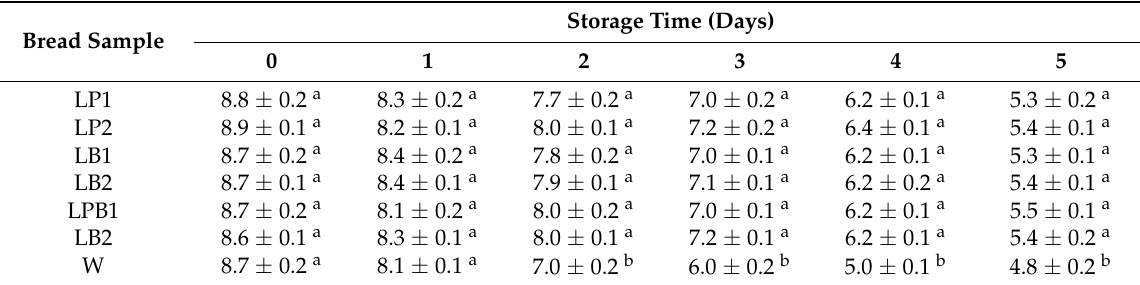
Table 4. Preliminary sensory evaluation test of breads made with sourdoughs prepared with freeze dried L. paracasei K5 and freeze-dried L. bulgaricus ATCC 11842 as well as with the control sourdough.